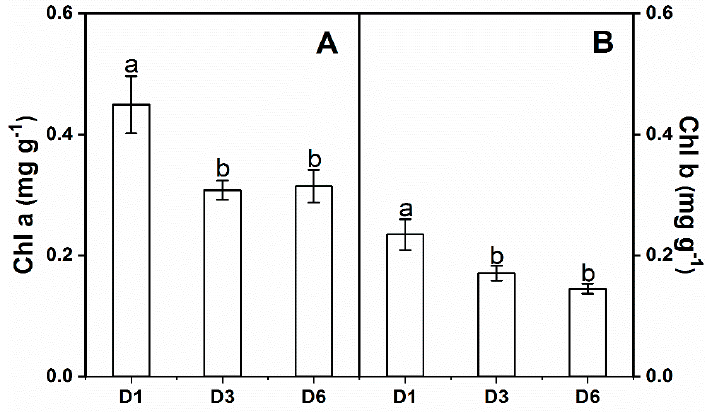
Figure 2. Comparisons of Chl a ( A ) and Chl b ( B ) of R. pseudoacacia from different rainfall intensity and rainfall frequency treatments (mean ± SE, n = 5) at the end of the experiment. Different letters within the same column denote significant differences at p ≤ 0.05 according to Tukey’s − HSD test. W1, W2, and W3: 75%, 55%, and 35% of field capacity, respectively. D1, D3, and D6: every day, every 3 days, and every 6 days of watering, respectively.